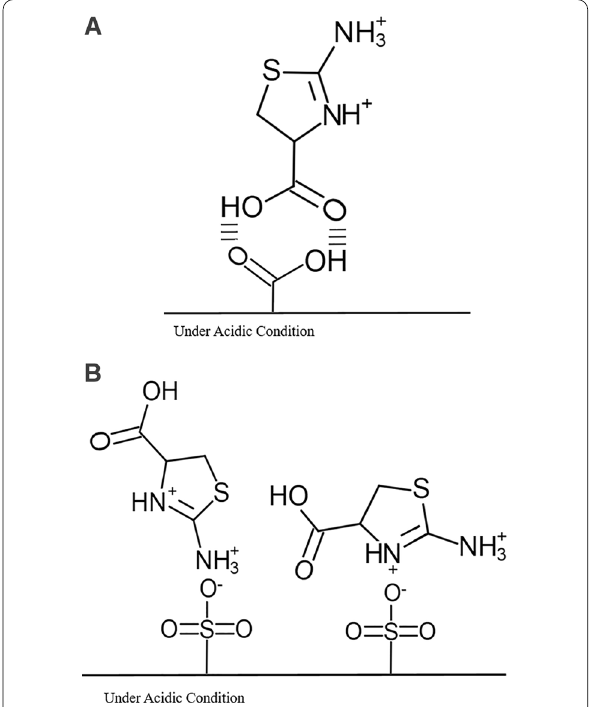
Fig. 1 Proposed extraction mechanism for ATCA in a Mag-CNTs-COOH/d-µSPE and b Mag-CNTs-SO 3